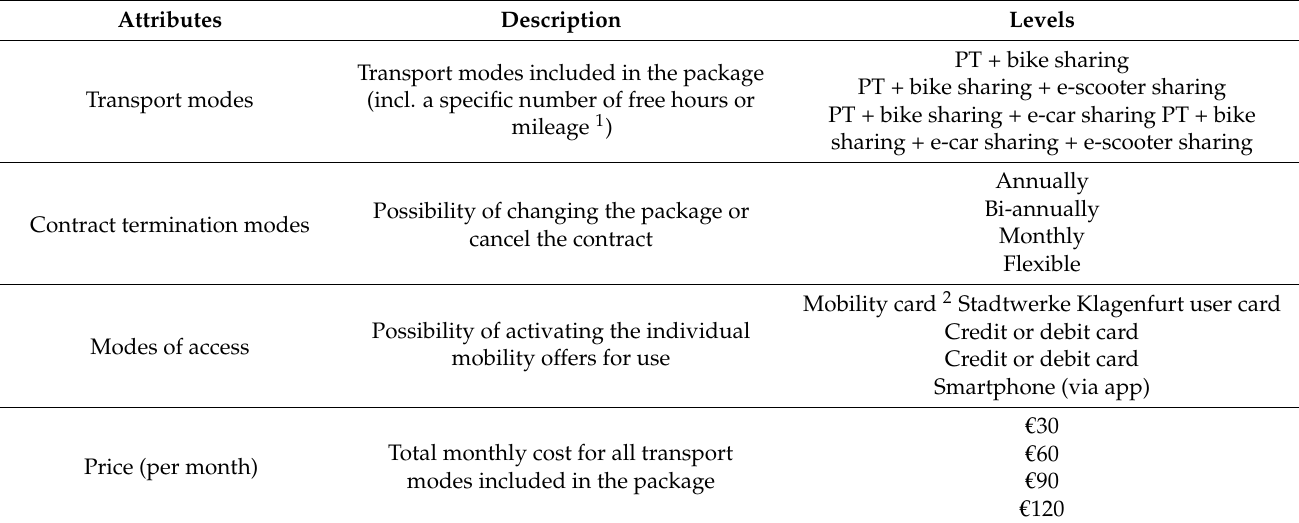
Table 1. Attributes and attribute levels included in the choice-based conjoint (CBC)